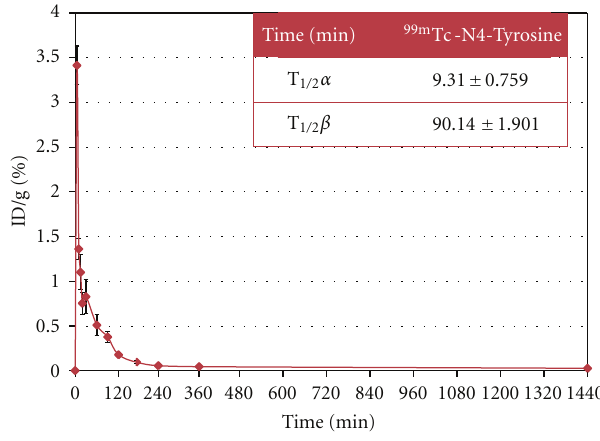
Figure 4: Blood clearance curve of 99m Tc-N4-Tyrosine in normal female Fischer 344 rats ( n = 3). Mean radioactivity is expressed as mean percentage of the injected dose per gram of blood ± standard deviation (%ID/g ± SD).